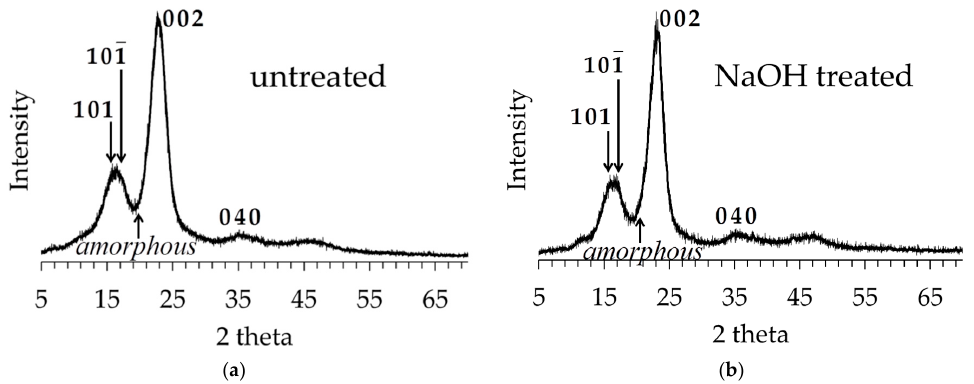
Figure 8. XRD spectra of untreated ( a ) and NaOH-treated ( b ) abaca fibers.